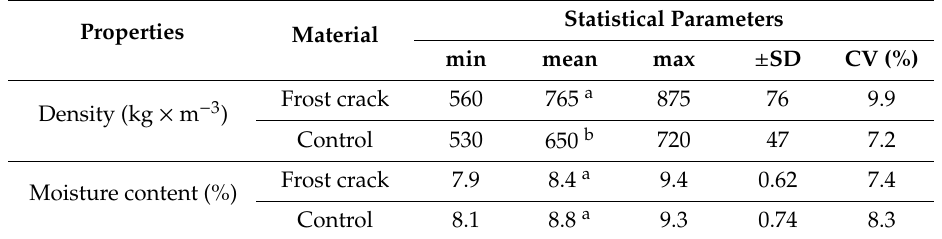
Table 3. Basic statistical parameters of the density ( ρ ) of oak wood species with and without frost cracks (standard deviation, SD; coe ffi cient of variation,